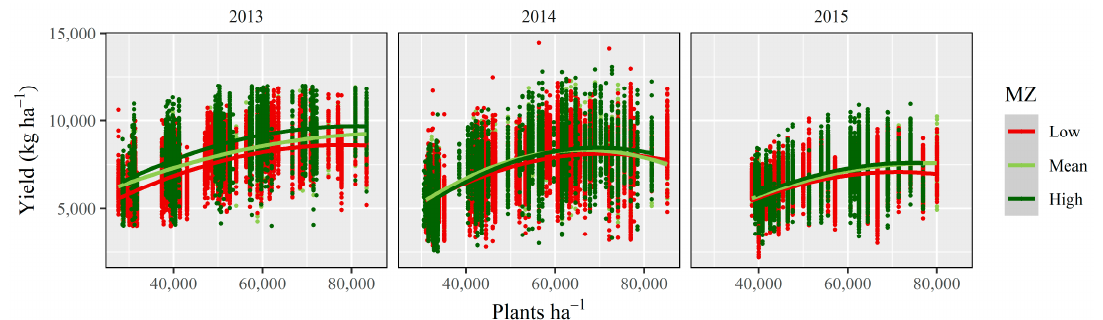
Figure 9. Population effect on yield for the different management zones for the second crop harvest (maize) of the years 2013, 2014, and 2015.